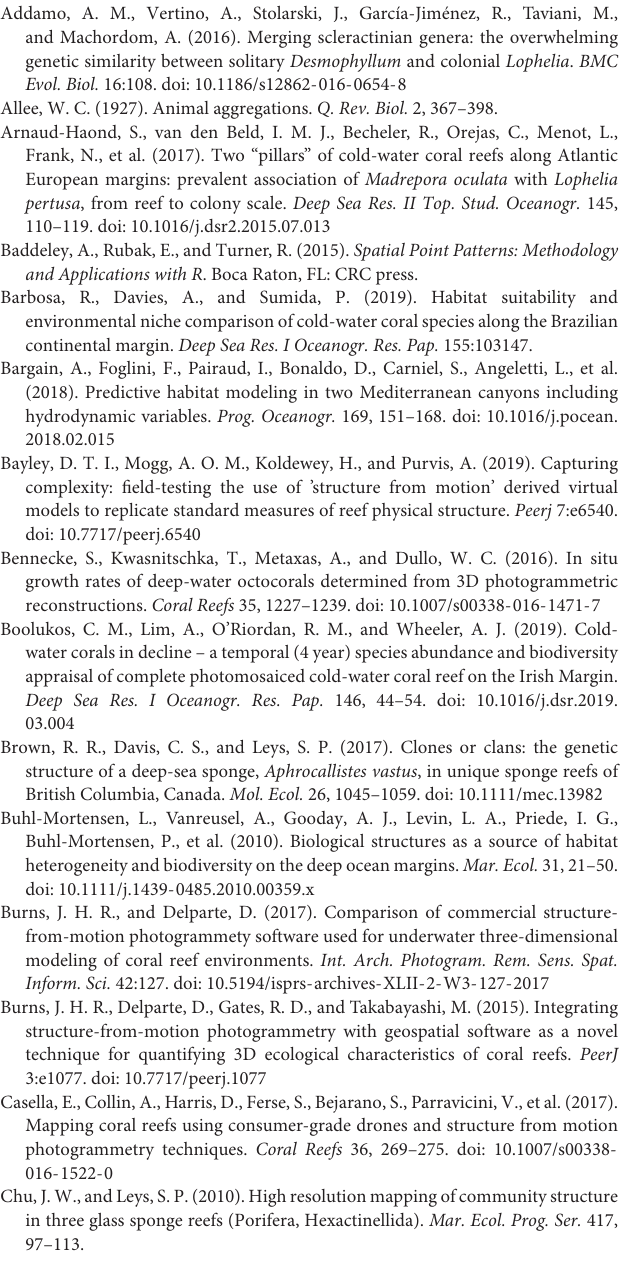
Measure, depth and substrate), CP (Geyer’s point interaction) and ICP (Northness, Vector Ruggedness Measure, Substrate and Geyer’s point interaction). Supplementary Figure 6 | Pair correlation function of Desmophyllum pertusum at Site A compared to the null models representing CSR, IP, CP, and ICP. Supplementary Figure 7 | Estimated function ρ (VRM) giving the estimated Aphrocallistes sp. density intensity as a function of Vector Ruggedness Measure (VRM) at Site A. VRM was calculated at multiple resolutions and neighbourhood scales (indicated in brackets following pixel size). Vertical solid line represents the mean VRM value of the reef substrate. Supplementary Table 1 | Results from chi squared goodness of fit